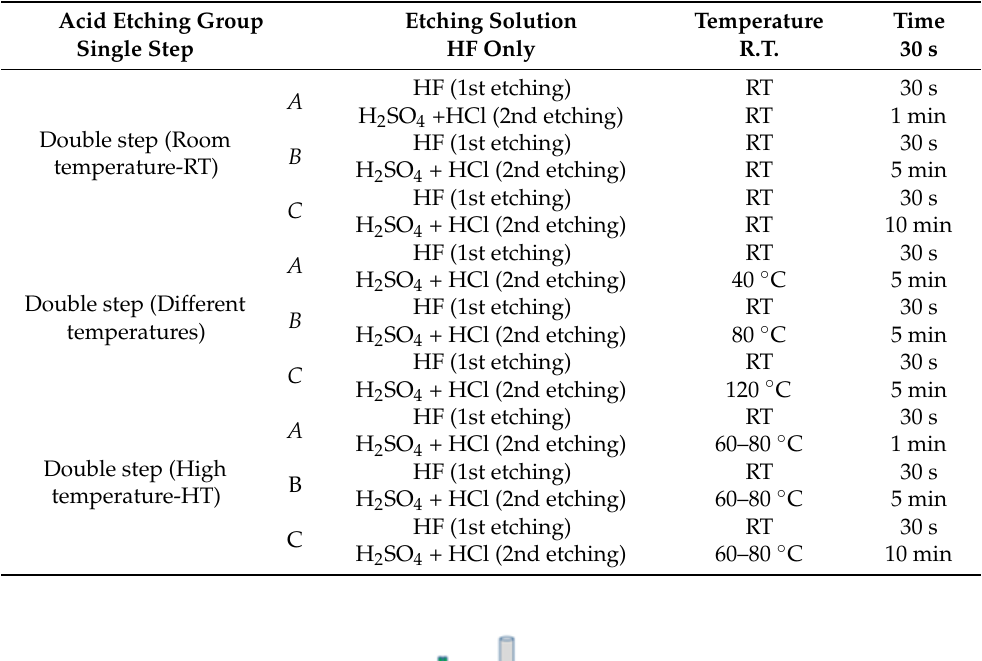
Table 1. Experimental parameters used in the study.